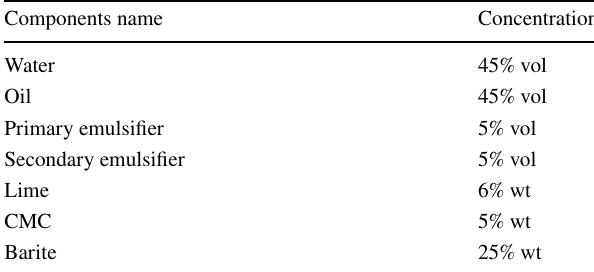
Table 1 The percentage of drilling fluid components Components name